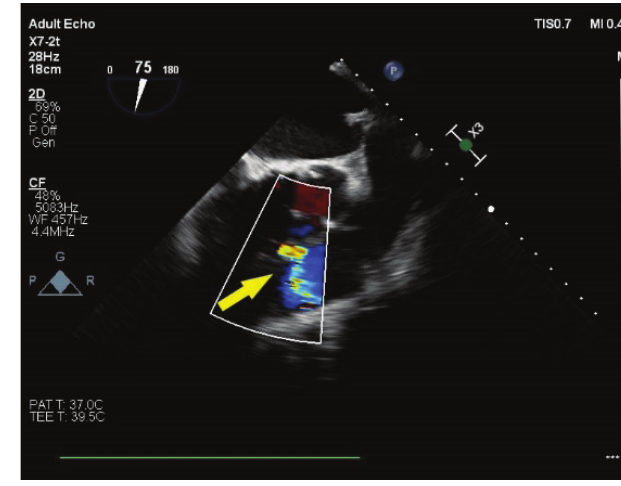
Figure 5 - Two-dimensional transthoracic echocardiogram parasternal long axis (PLAX) view with color flow doppler of fistula tract (arrow)